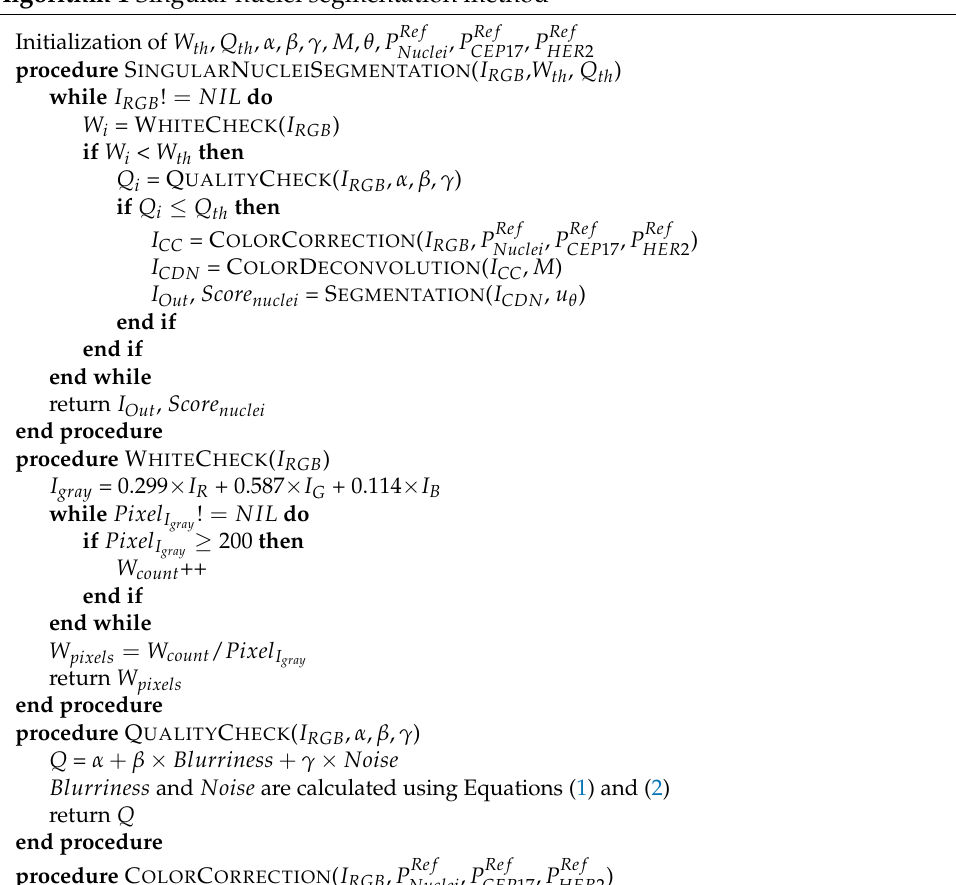
Algorithm 1 Singular nuclei segmentation